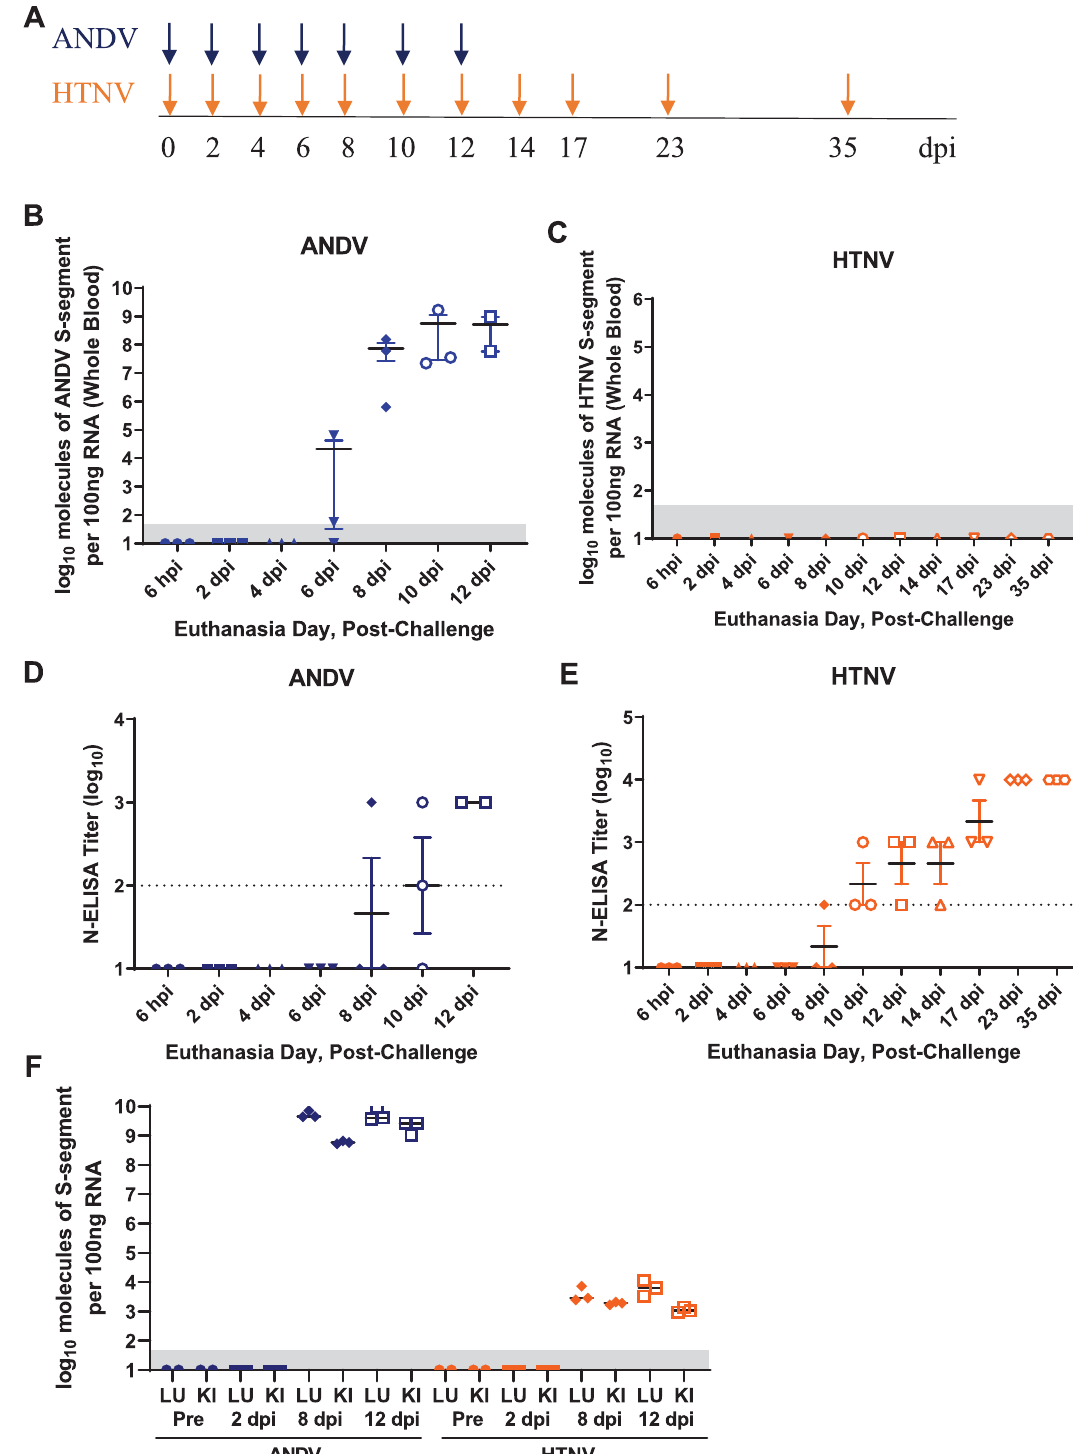
Fig 1. Hantavirus Infections in Syrian Hamsters. A) Groups of 3 hamsters each were exposed to either 2,000 PFU ANDV or HTNV and euthanized on the indicated dpi (ANDV, blue arrows; HTNV, orange arrows). RNA from whole blood from B) ANDV- and C) HTNV-infected hamsters was analyzed for viral RNA by RT-PCR (limit of detection is 50 copies, shaded area). N-ELISA endpoint titers (log 10 ) were conducted with serum collected from D) ANDV- and E) HTNV-infected hamsters at the time of euthanasia. F)